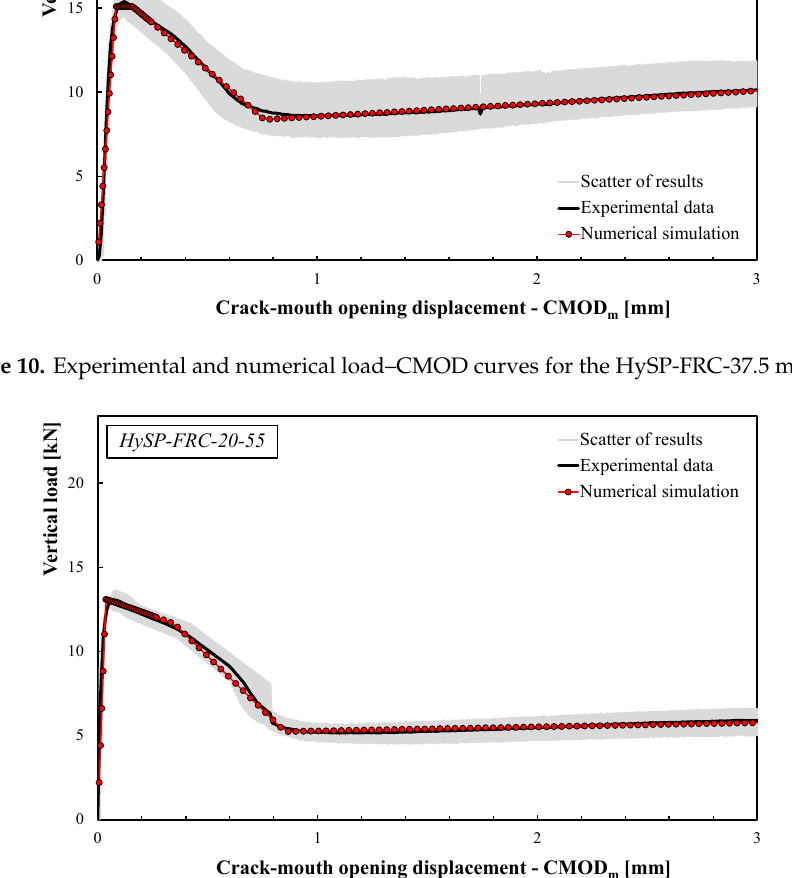
Figure 11. Experimental and numerical load–CMOD curves for the HySP-FRC-20-55 mixture.